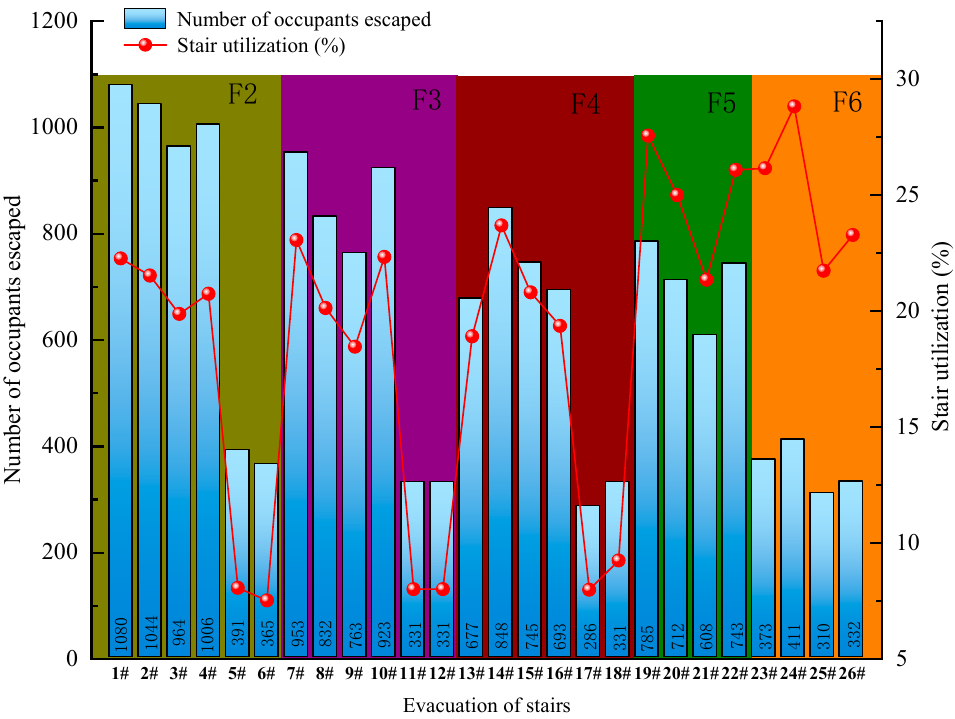
Figure 5. Evacuation under normal conditions.